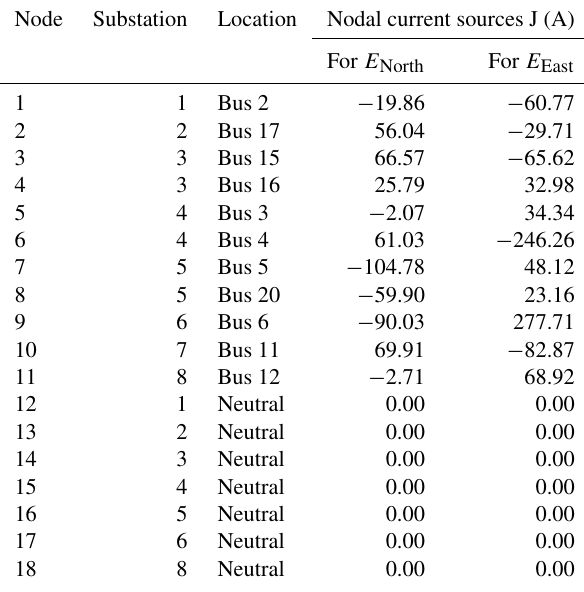
Table 6. Nodal current sources for northward and eastward electric fields of 1Vkm − 1 .